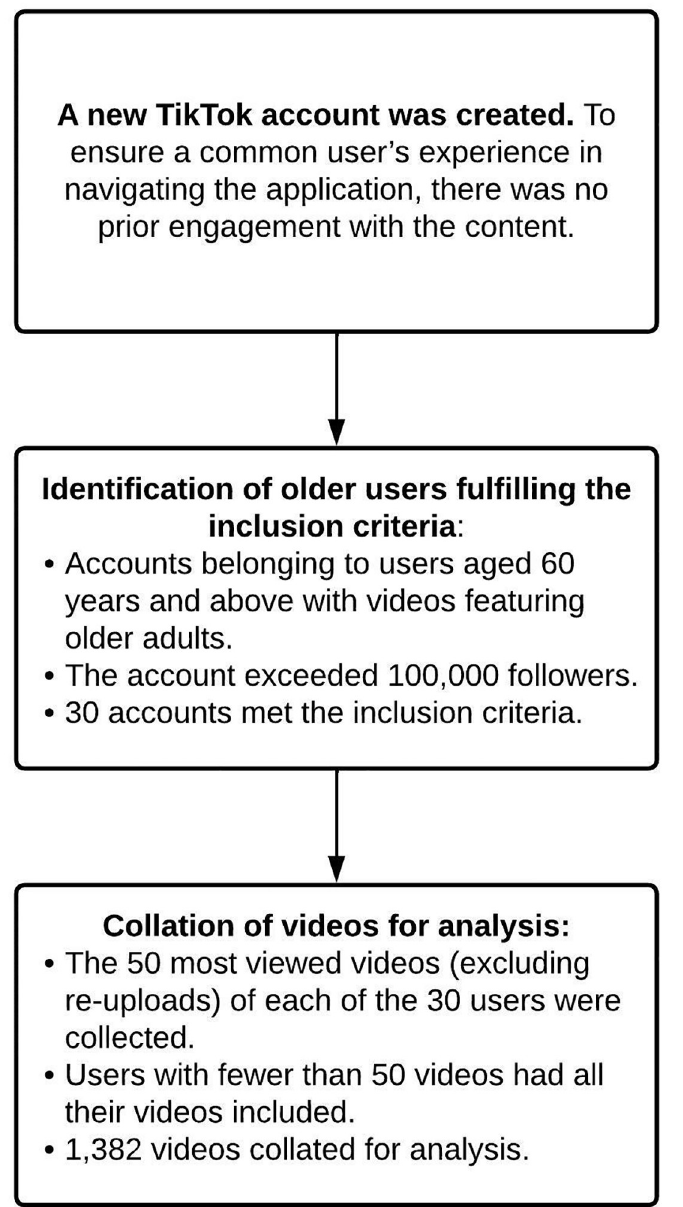
Fig 1. Process of collating TikTok